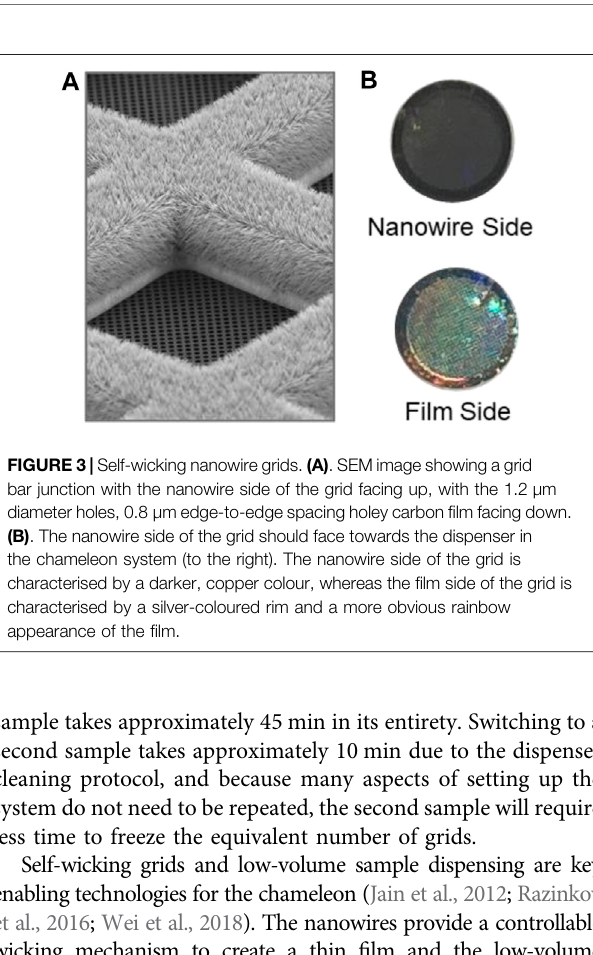
Frontiers in Molecular Biosciences |